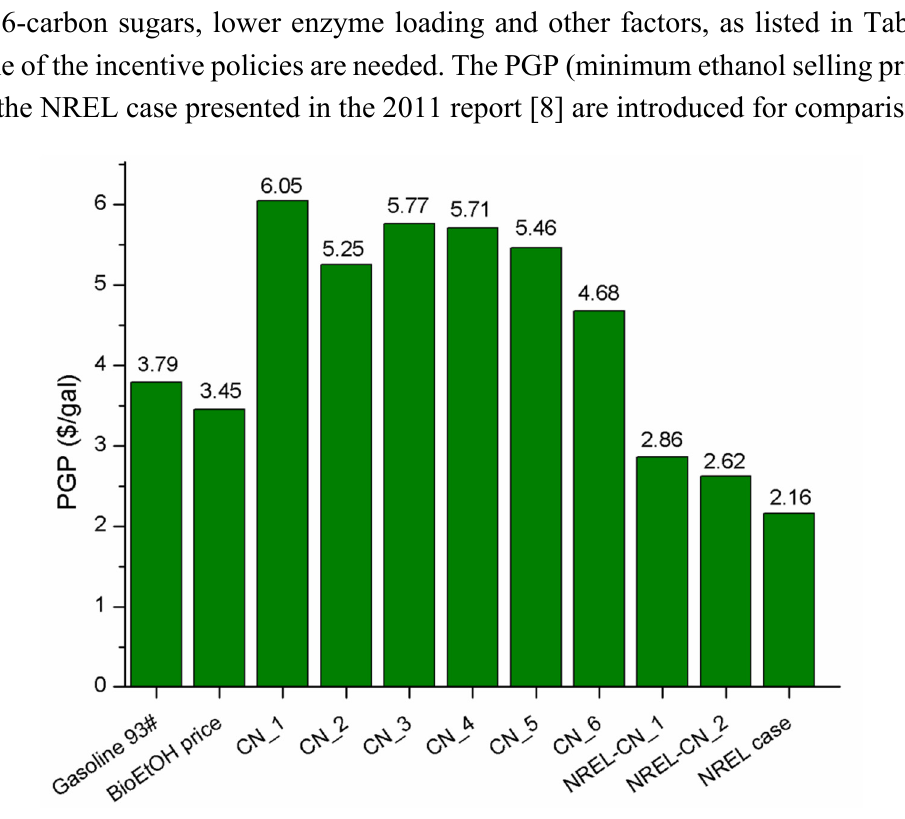
Figure 4. Current bioethanol selling price in China, PGPs of gasoline 93 # and lingo-cellulosic ethanol in different scenarios, and bioethanol PGP in NREL